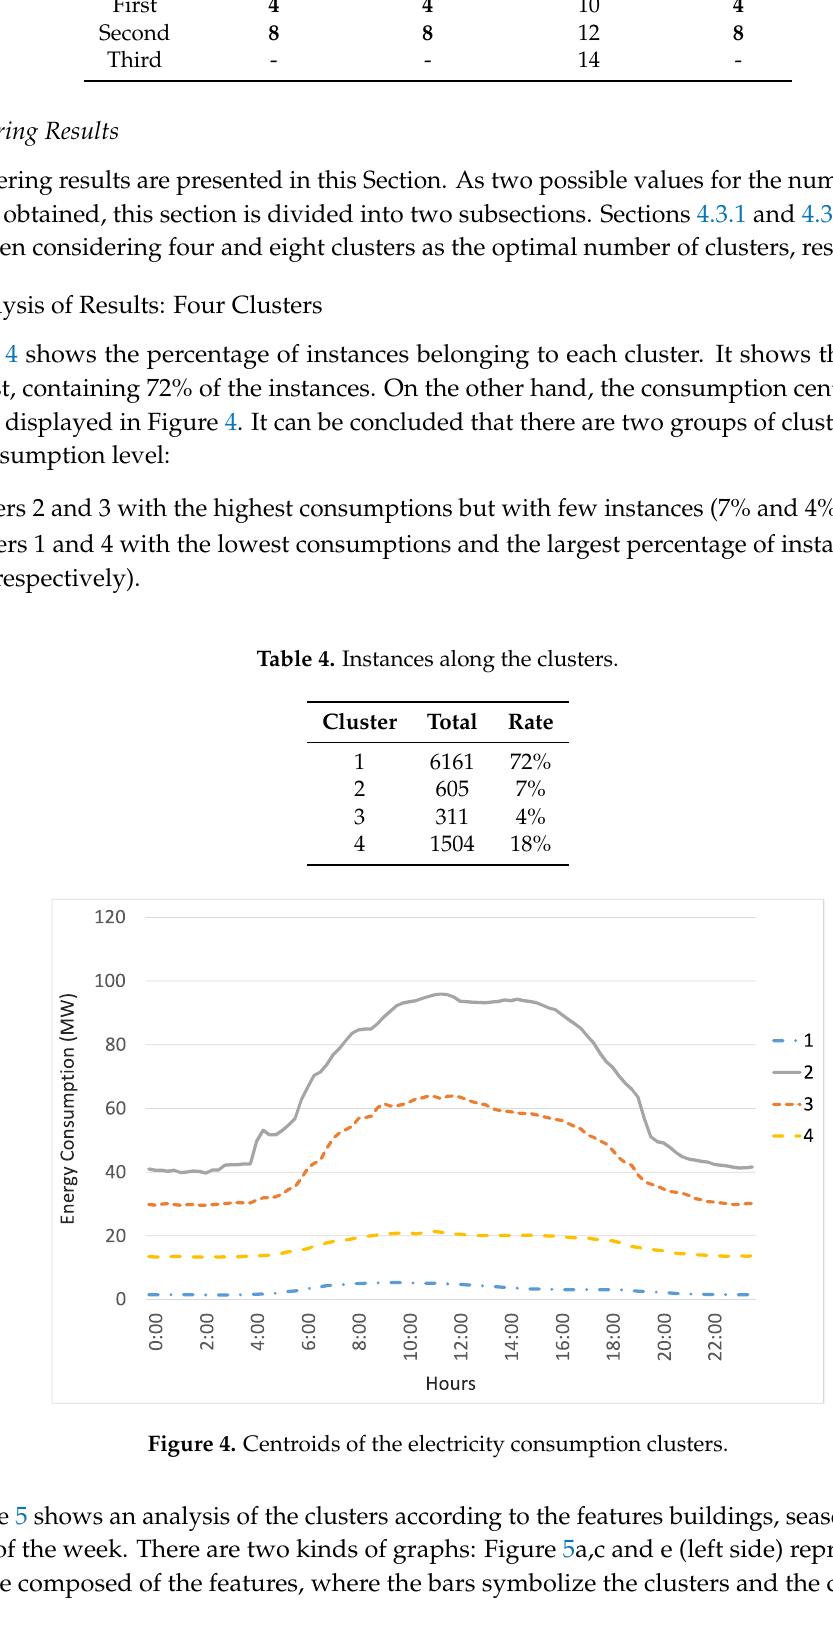
Figure 4. Centroids of the electricity consumption